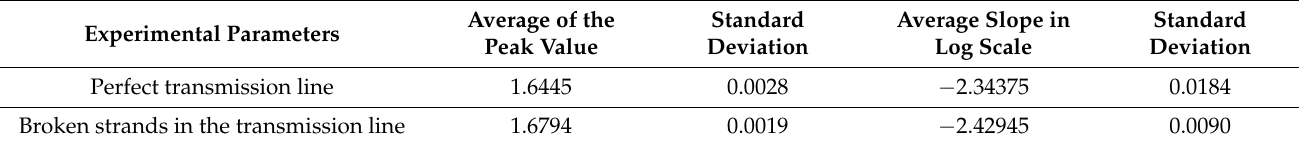
Table 3. Repeatability of the testing results for the different probe